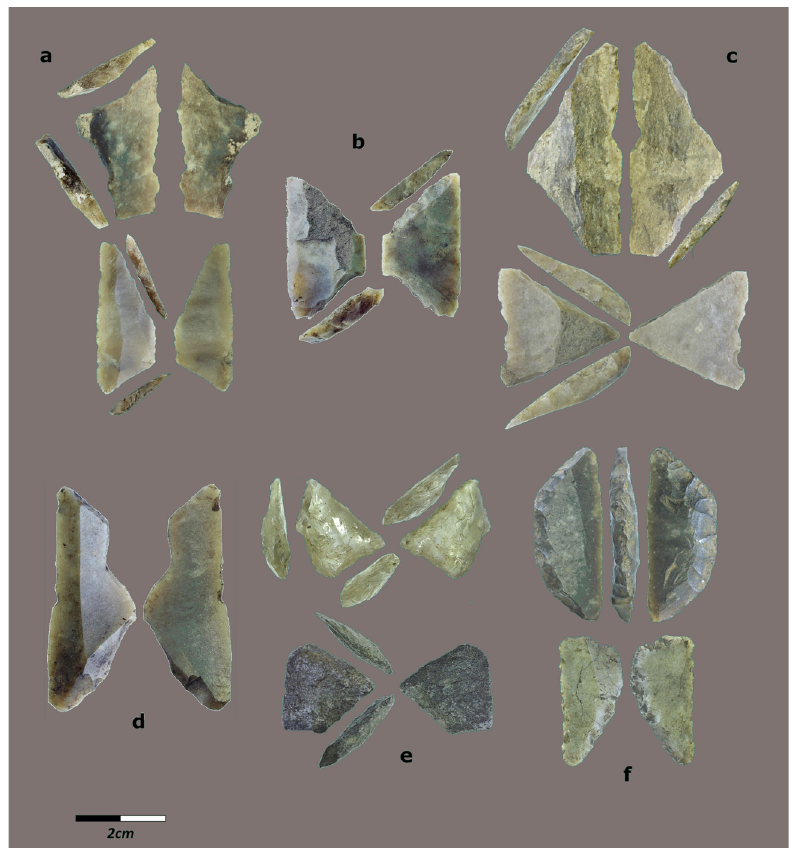
Figure 3: Geometric microliths from the second phase of occupation at Obagues de Ratera ( 5732 – 5638 cal BCE ) . Legend: ( a ) trapezes ( direct abrupt retouch ) , ( b ) trapeze ( alternate abrupt retouch ) , ( c ) trapeze ( alternate abrupt retouch ) , ( d ) triangle ( direct abrupt retouch ) , ( e ) triangles ( double - bevelled ) , and ( f ) segments ( double - bevelled )